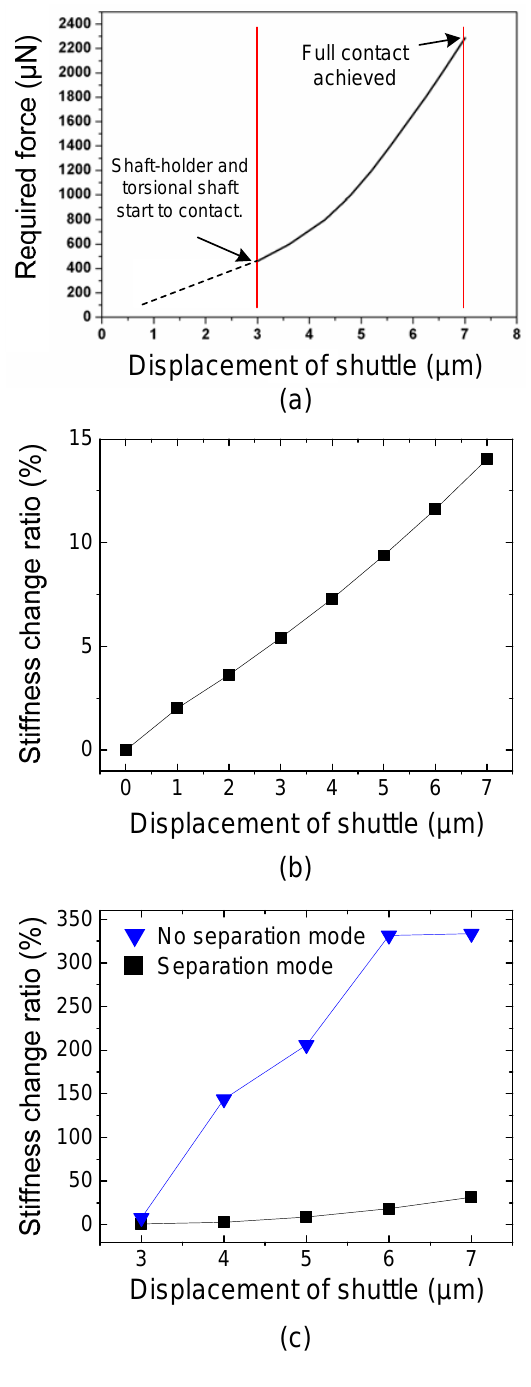
Figure 5. Finite element analysis (FEA) results: ( a ) Required force from the chevron thermal actuator to achieve full-contact between the shaft-holder and torsional shaft (shaft-holding type); ( b ) Estimated torsional stiffness change by shaft-widening type ( c ) Estimated torsional stiffness change by shaft-holding type. ‘No separation mode’ and ‘separation mode’ correspond to the restriction modes illustrated in Figure 6a,b, respectively.